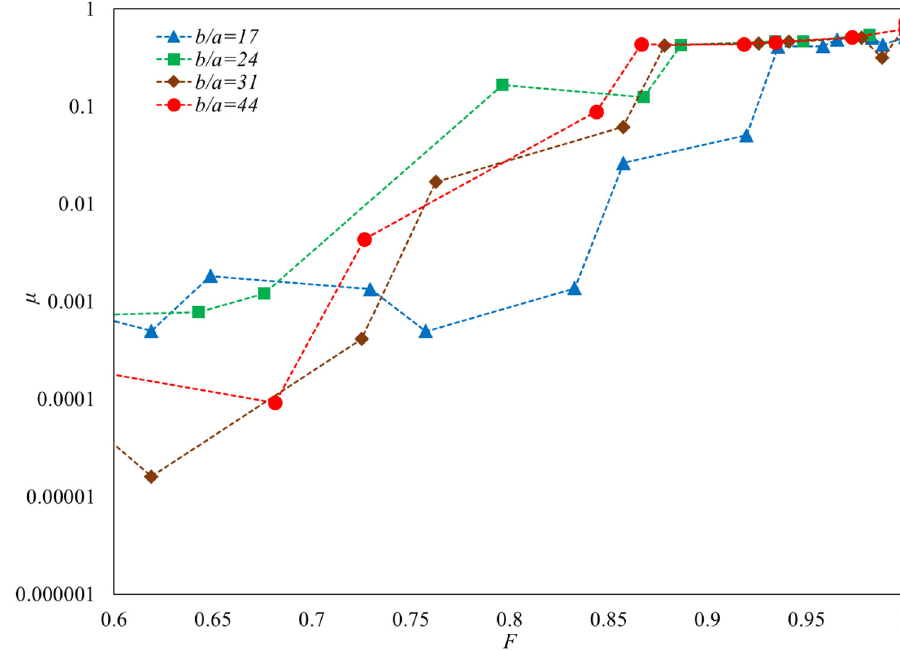
Fig. 7. Penetration ratio m as a function of the solid fraction F for different b/a ratios at d